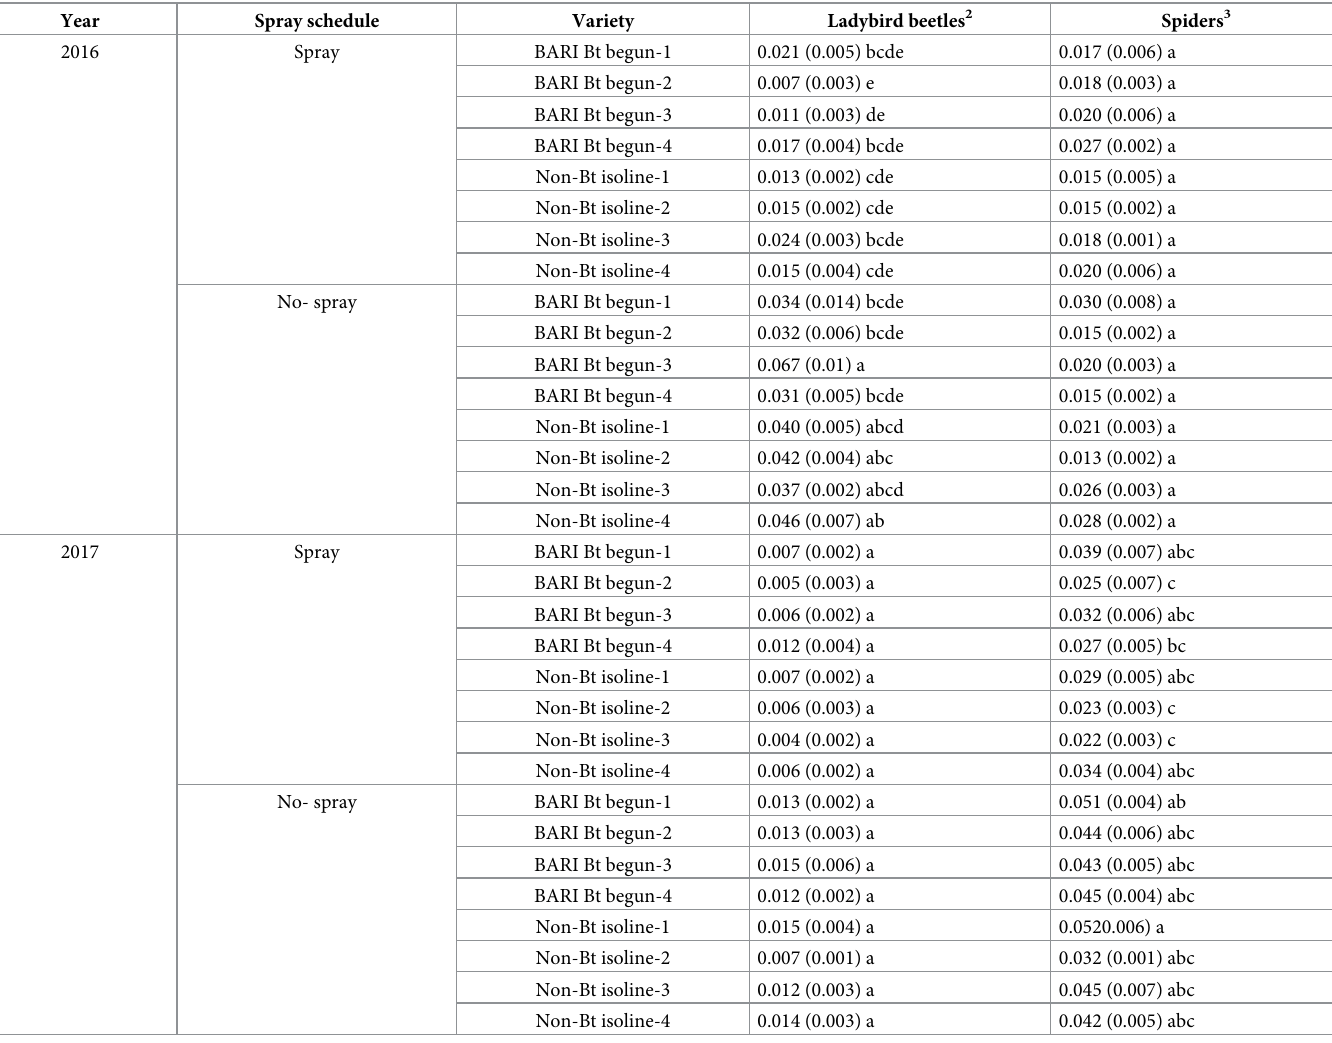
Table 4. Mean abundance 1 of non-target beneficial arthropods (No./leaf) in brinjal relative to insecticides and varieties, OFRD, BARI, Bogra,